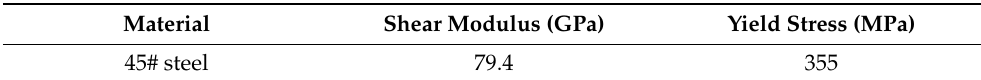
Table 3. 45# steel parameters